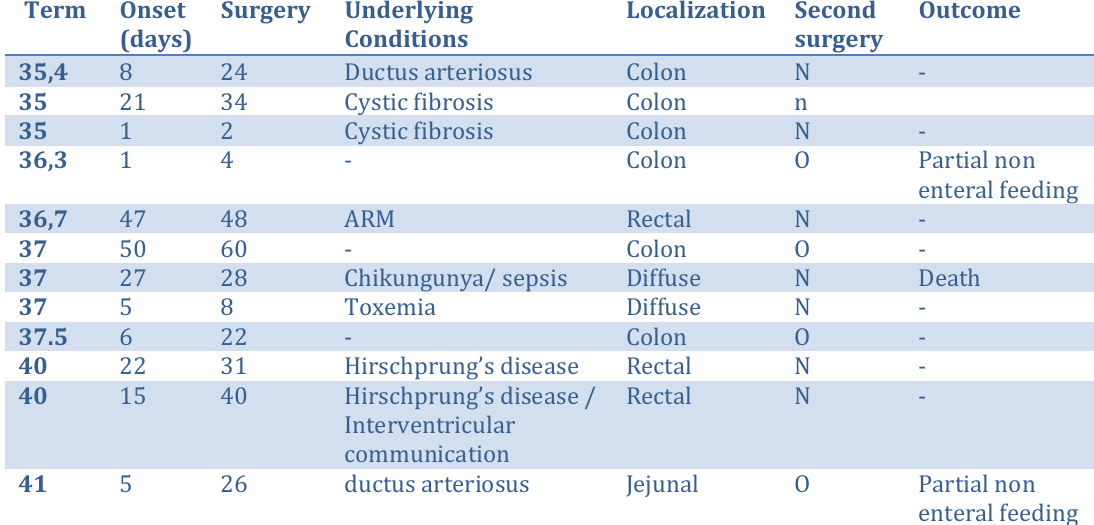
Table1: Specificities of patients requiring surgery for